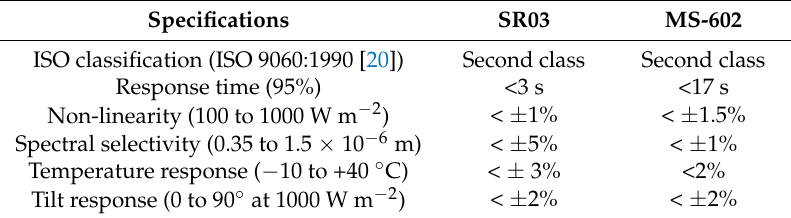
Figure 1. A mobile multipyranometer array (MMPA) system. Table 1. Specifications of the